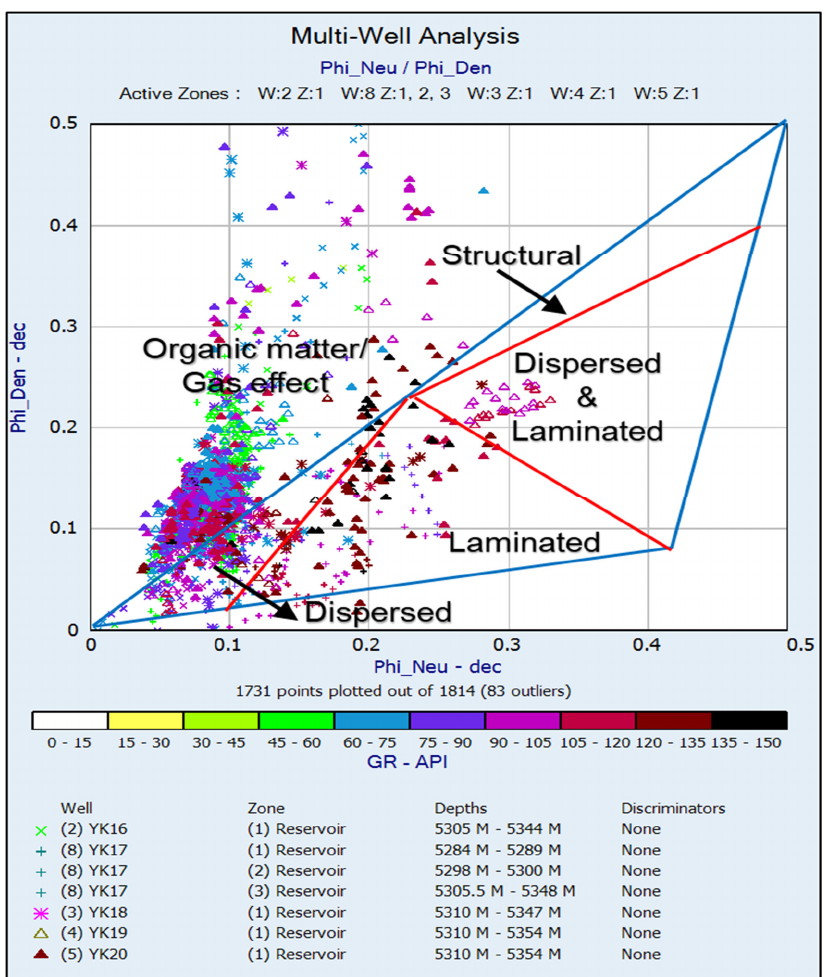
Figure 19. Phi Den/Phi Neu cross plot for multi-well analysis with a discriminator gamma ray. The response indicates the shale distribution types in reservoir